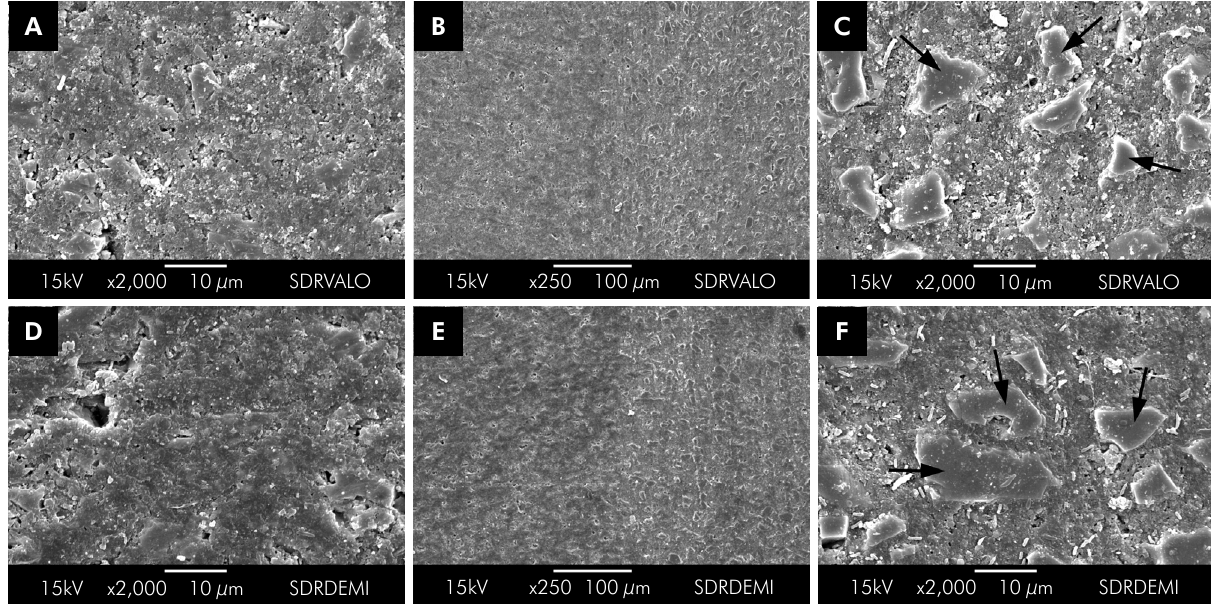
Figure 4. SEM images (250 x and 2000 x) showing the surfaces (unbrushed/control and brushed sides) of SDR. A- unbrushed area, B- border area between unbrushed control and brushed sides and C- brushed area polymerized with Valo. D- unbrushed area, E- border area between unbrushed control and brushed sides, and F- brushed area polymerized with Demi Ultra (arrows indicate the filler particles exposed on composite surface after brushing).